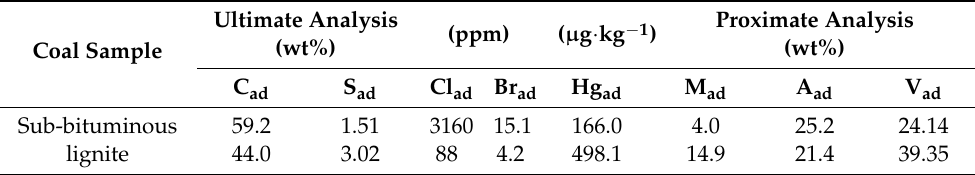
Table 6. Characteristic of the coals used in the experiment (in the air-dry